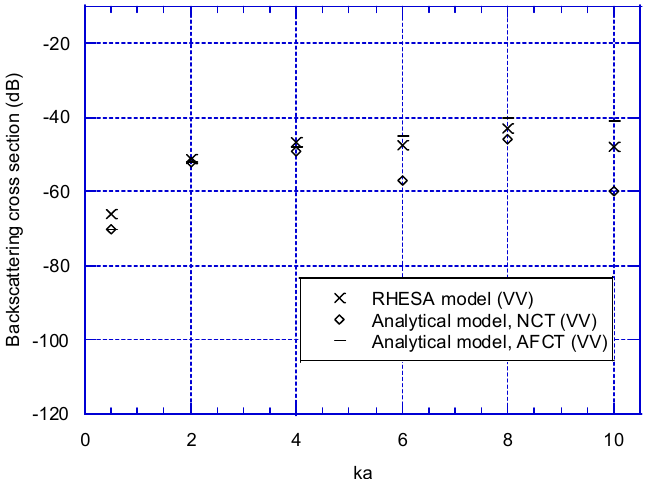
Figure 4. Comparison between theories for backscattering cross section of a cylindrical scatterer against ka, at an incident angle of 20 degrees.